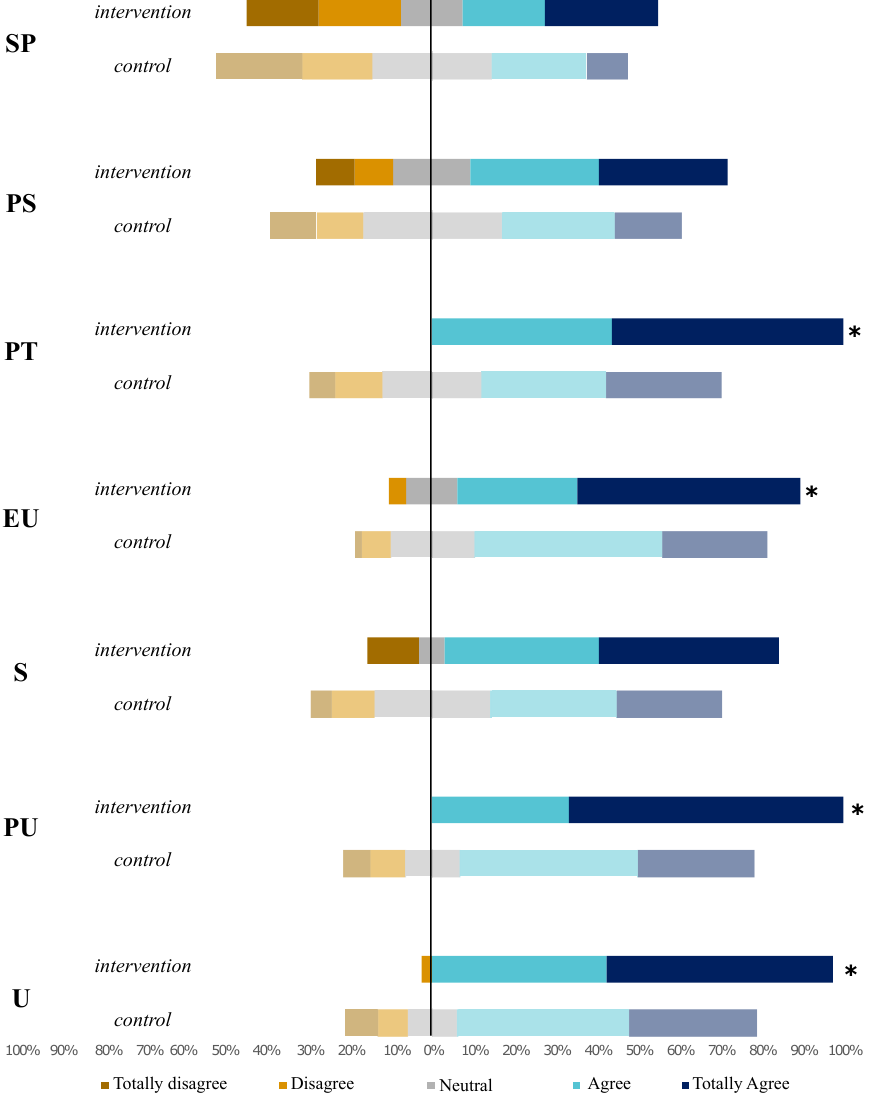
Figure 5. Likert scale distribution for each construct of the acceptance and perception questionnaire applied to